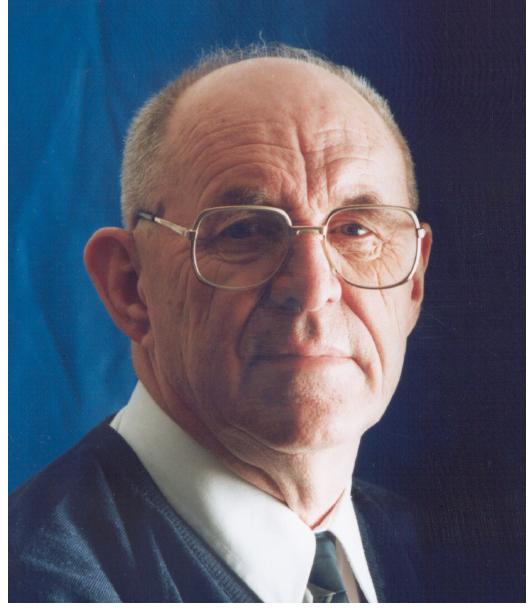
Figure 16: Jens Glad Balchen photographed in 1997 on the occasion of his article summarizing over 40 years of efforts in engineering cybernetics at NTH (Balchen, 1997). Photo: Gøril Klemetsen. Not that he had plans to depart anywhere.